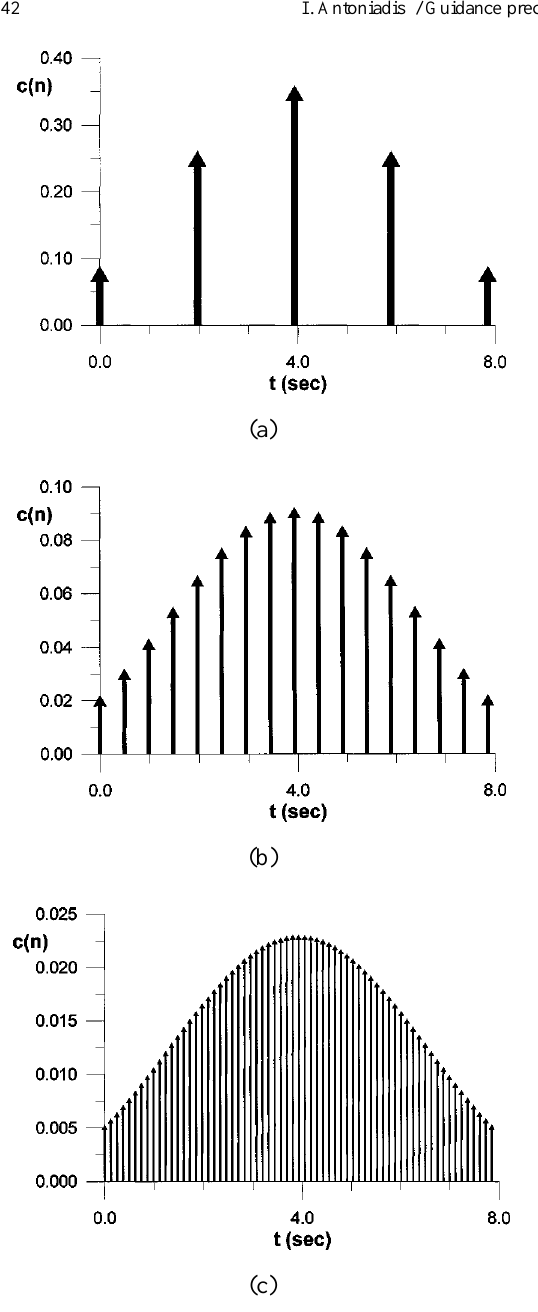
Fig. 7. Fourier I impulse sequences for T p = 2 : 5 (cid:25) . (a) N = 4, (b) N = 16, (c) N = 64. sulting however to abrupt control actions. Based on